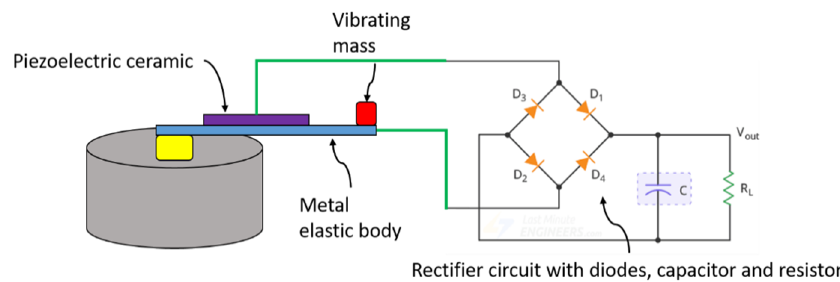
Figure 14. Piezoelectric based biomechanical electricity generation principle, redrawn from the schematic shown in [291].